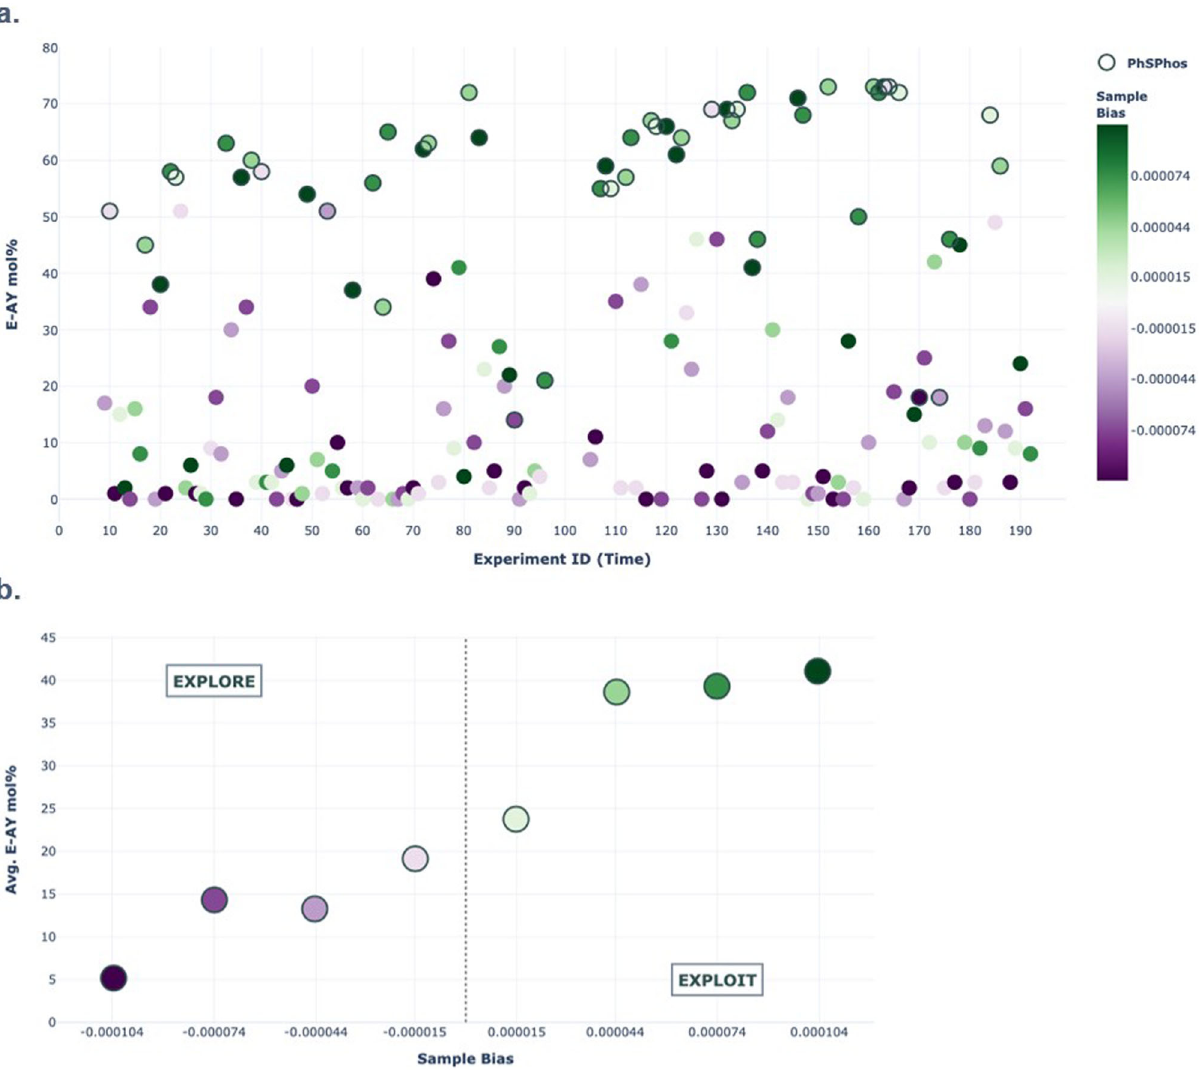
Fig. 8 Two-dimensional plots of 2- E yield for each experiment ID and average 2- E yield for each sample bias value in campaign 2. a Green indicates positive, exploitative sample bias values, while purple indicates negative, explorative sample bias values. PhSPhos results are outlined; all other ligand results are not outlined. b Green indicates positive, exploitative sample bias values, while purple indicates negative, explorative sample bias values.